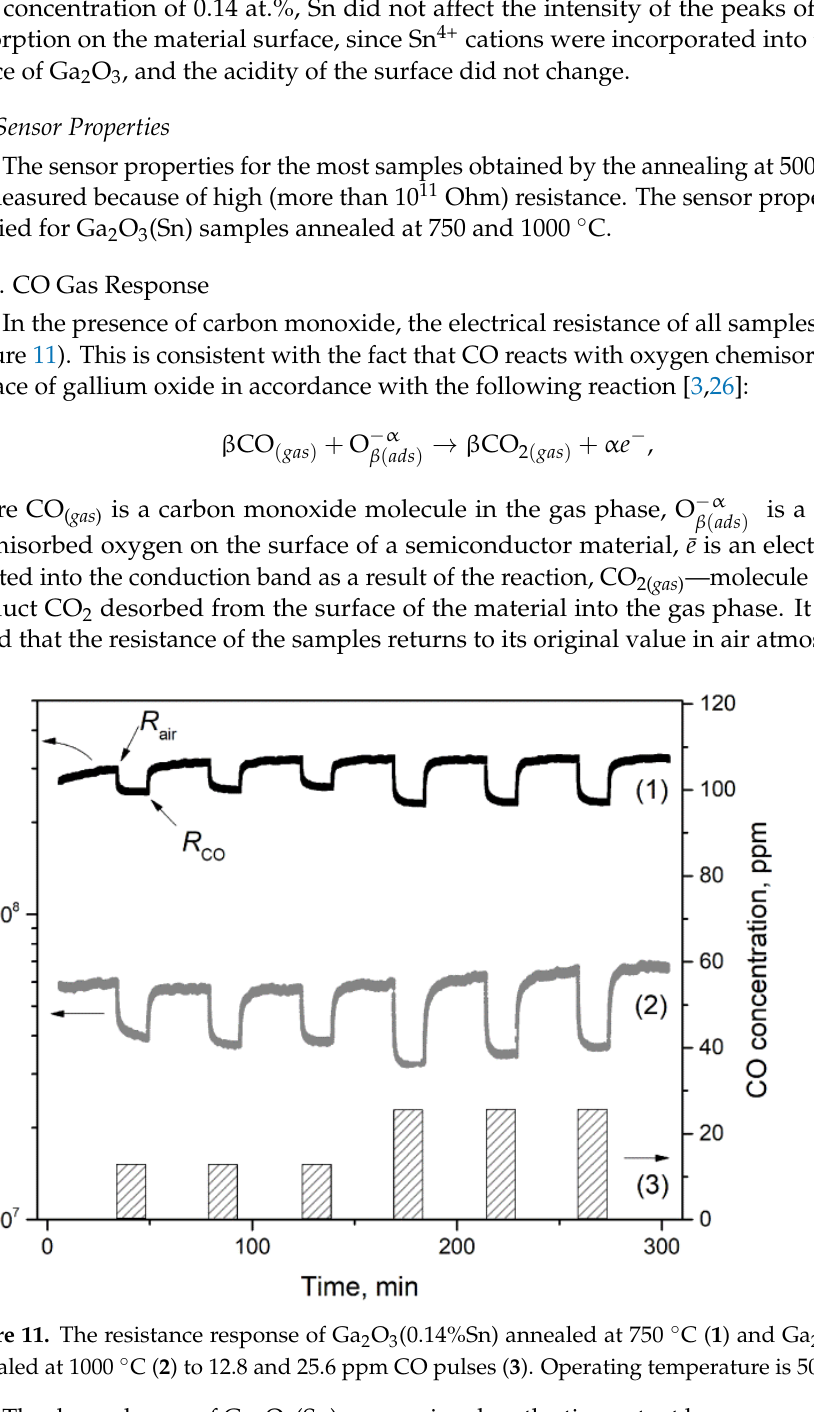
Figure 12. Sensor signal S to 256 ppm CO as a function of Sn content x for samples obtained by annealing at ( 1 ) 750 and ( 2 ) 1000 °C. The measuring temperature is 500 °C. The dependencies of sensor signal S on the CO concentration in air are represented in Figure 13. Tin-doped Ga 2 O 3 (Sn) samples allow to determine 12.8 ppm of CO while pure Ga 2 O 3 samples were able to determine only high concentrations of carbon monoxide in air (256 and 102–256 ppm for Ga 2 O 3 samples obtained at 750 and 1000 °C, respectively). The deviation from linearity of the plots at high CO concentrations may be due to incomplete desorption of CO 2 or formation of surface polydentate carbonate species, which could oc- cupy some adsorption sites and lead to a decrease in the sensor response. Carbon dioxide acts as Lewis acid and accepts electrons from the semiconductor material surface, and the growth of free electron concentration with Sn content leads to the increase in adsorbed CO 2 molecules. It was shown that as compared to most forms of carbonate groups the polydentate carbonate groups [24] and bicarbonate species [27] are more stable and were observed on Ga 2 O 3 surface at 450 ° С and up to 477 ° С , respectively. The adsorbed CO 2 or